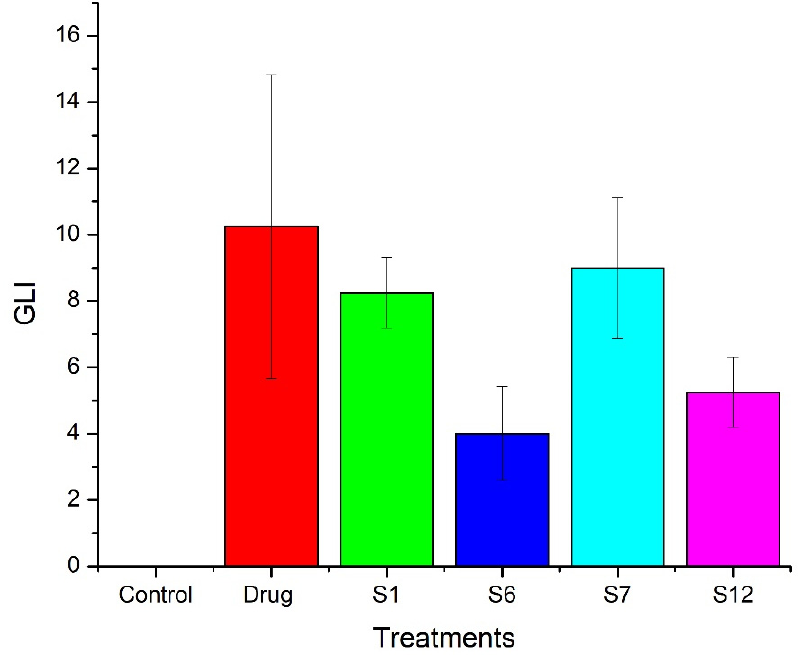
Figure 7. GLI in gastric mucosa of rats after different treatments.